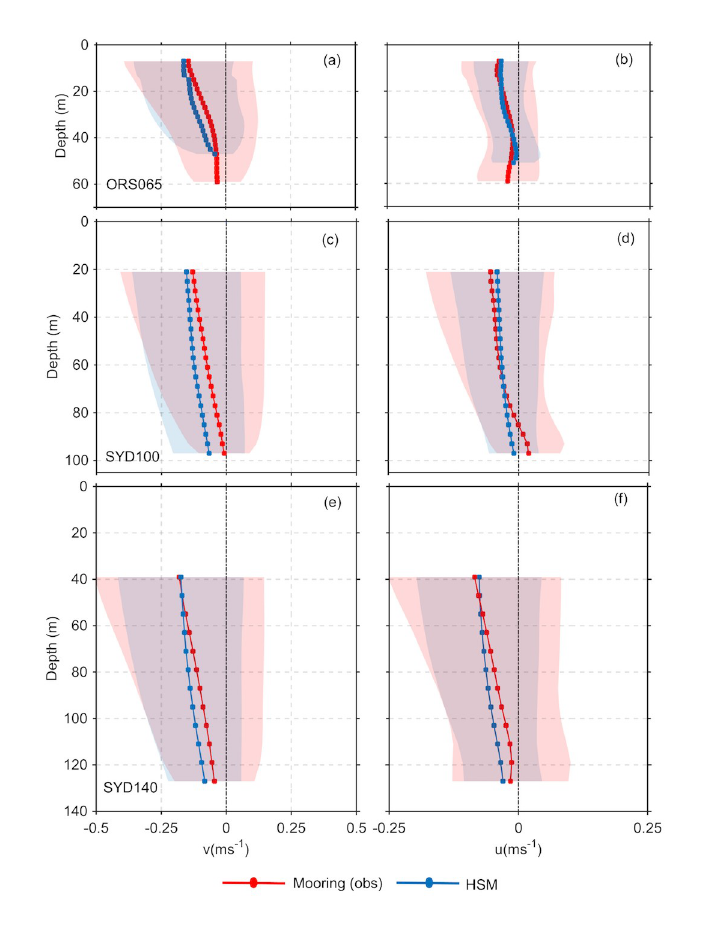
Fig 5. Observed (red) and modelled (black) along shore (v, left) and cross-shore (u, right) velocity profiles (ms -1 ) with depth at the three shelf moorings, ORS065 (a,b), SYD100 (c,d), and SYD140 (e,f). Shading represents the standard deviation and mooring locations are shown in Fig